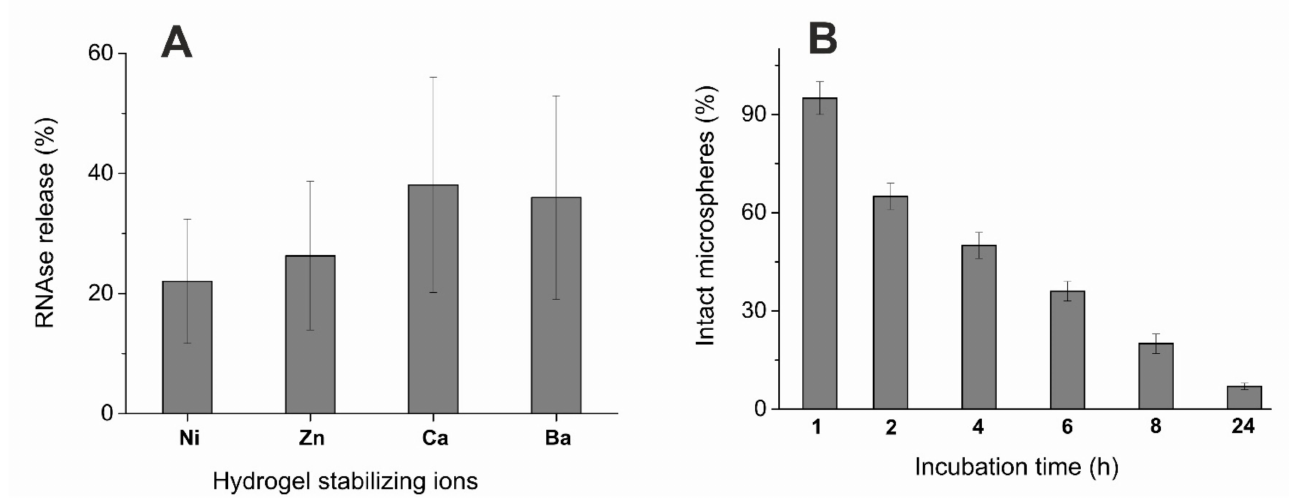
Figure 5. Binase release from cation–alginate microspheres in 50 mM Tris-HCl pH 7.4, 4 h after loading ( A ) and decrease of intact calcium–alginate microspheres proportion in 0.01 M PBS pH 7.2, depending on incubation time ( B ). At panel A, 100% of the amount of enzyme in solution after total microsphere destruction was taken. At panel B, 100% of the number of microspheres visually detected as intact ones, including microspheres with partially injured surfaces, was taken.